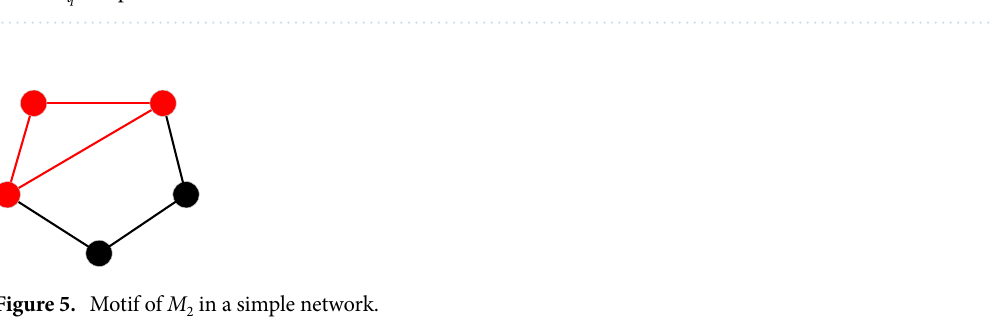
Table 1. Three-node and four-node (anti-) motifs. Max q is the maximum number of occurrences for (anti-) motif M q in a product structural network.